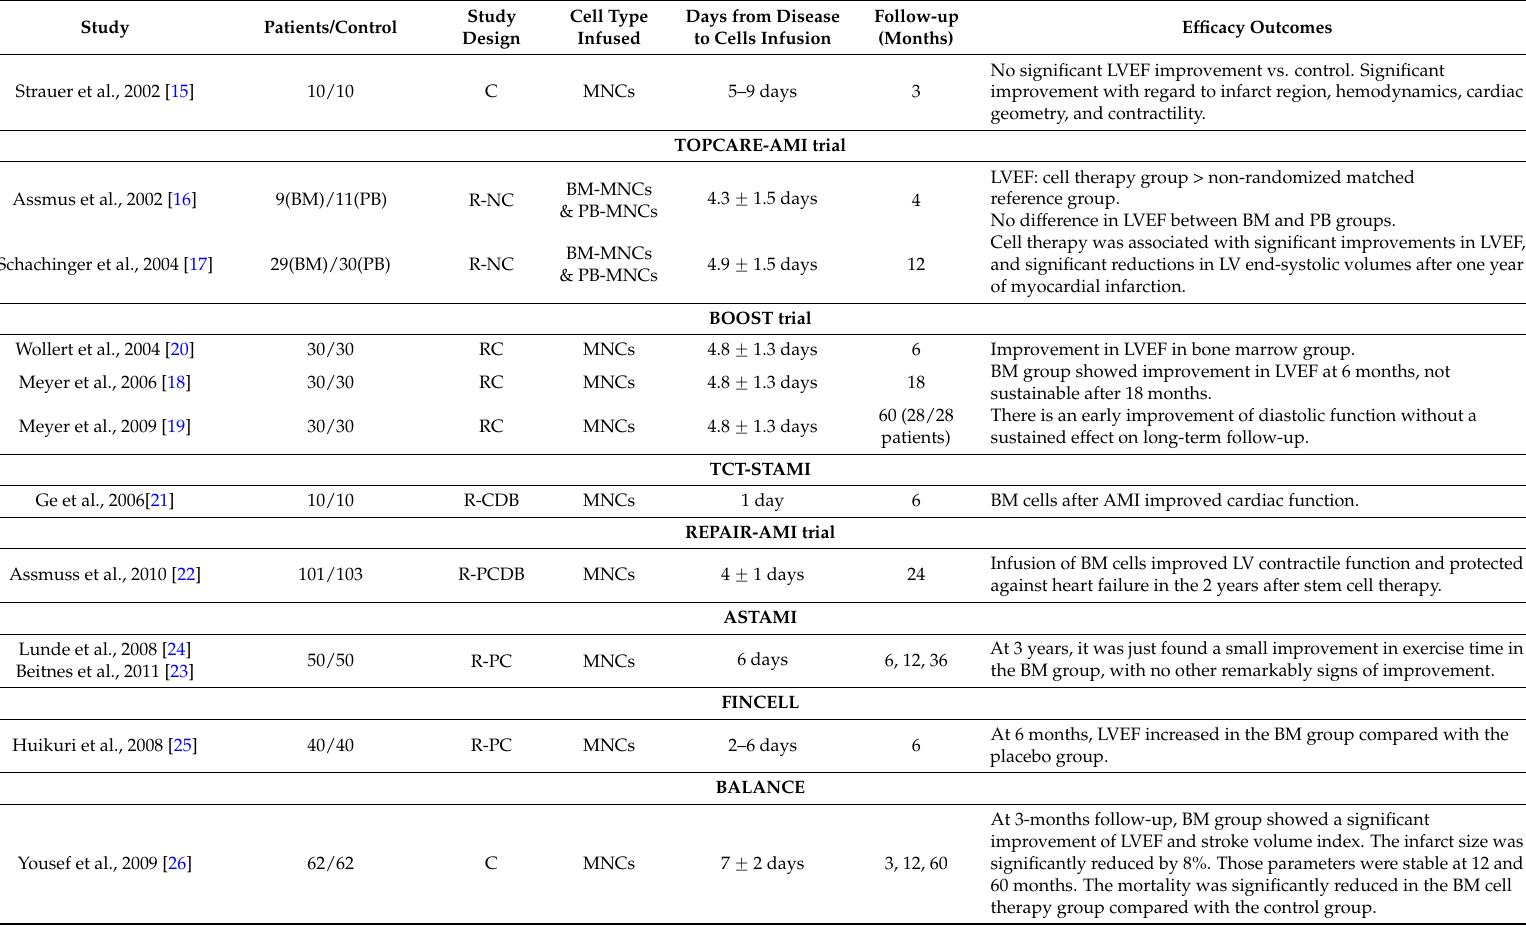
Table 1. Literature review of intracoronary delivery of autologous bone marrow stem cells in adult patients with ischemic heart